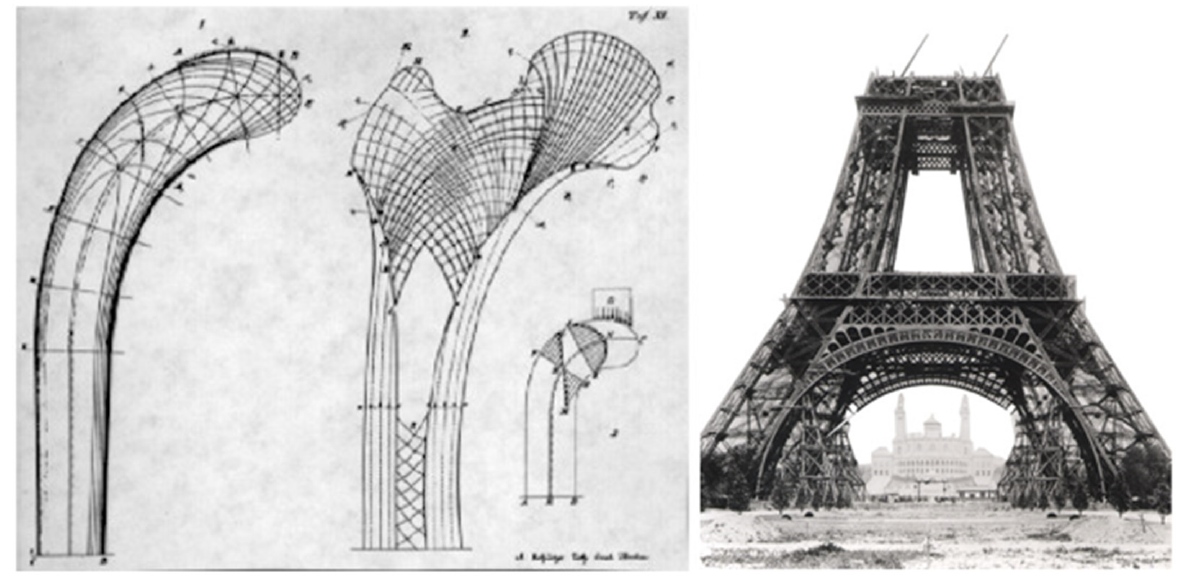
Figure 7. Crane principal stress lines and trabeculae lines on the femur ( left ) [49]; the base of the Eiffel Tower ( right ) (Source: Flickr.com).